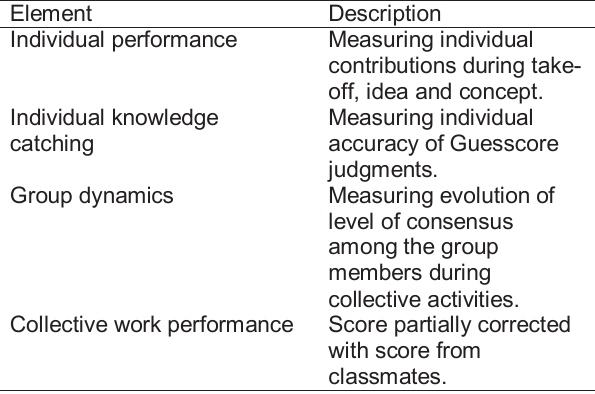
Table 4. Analytics of the Fabricius Teaching